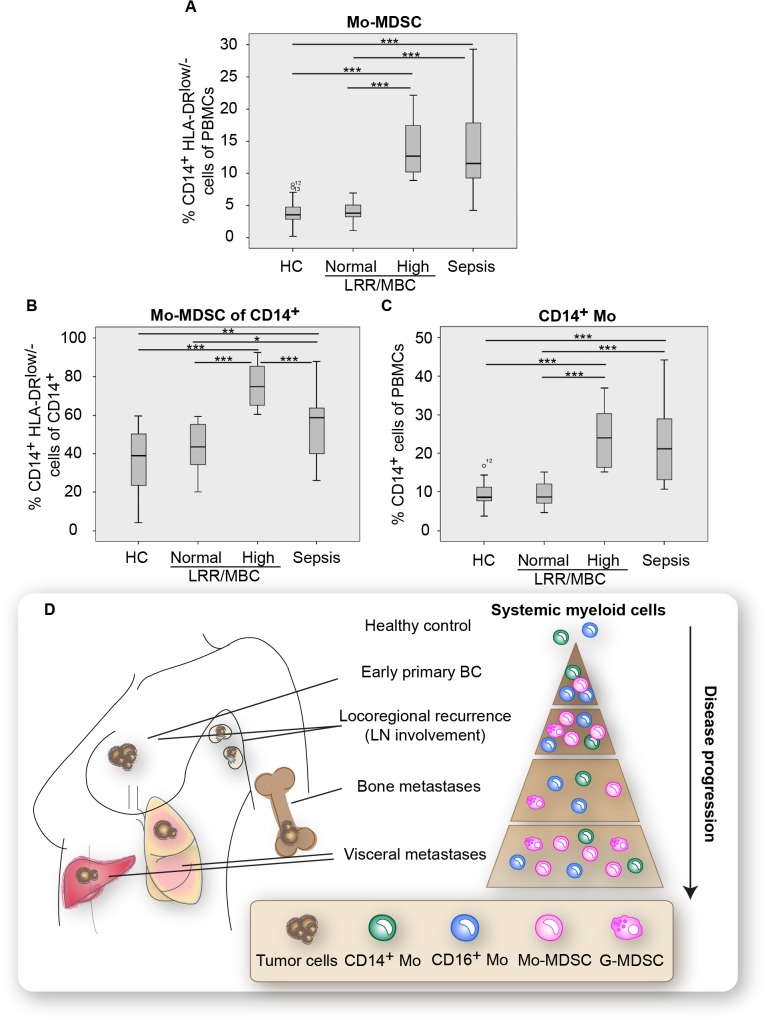
Mo-MDSCs are enriched in a subpopulation of patients with locoregional recurrence or metastatic breast cancer.(A-C) Flow cytometric analyzes of freshly isolated PBMCs from healthy controls (HC), patients with locoregional recurrence or metastatic breast cancer (LRR/MBC) or sepsis. The box plots represents the variation in respective cell population as percentage (%) of PBMCs. Cutoff into “normal” or “high” levels of Mo-MDSCs were based on the highest healthy control value. (A) Percentage of CD14+HLA-DRlow/- monocytes of PBMCs (HC n = 13, LRR/MBC “normal” n = 13, LRR/MBC “high” n = 12, Sepsis n = 18) or (B) within total CD14+ monocyte population (HC n = 13, LRR/MBC “normal” n = 13, LRR/MBC “high” n = 12, Sepsis n = 18). (C) Percentage of total CD14+ monocyte of PBMCs. HC n = 13, LRR/MBC “normal” n = 17, LRR/MBC “high” n = 8, Sepsis n = 18. (D) Cartoon presenting proposed frequencies of relevant systemic myeloid cell populations with disease progression. Abbreviations: Monocytes, Mo; Monocytic-MDSC, Mo-MDSC; granulocytic-MDSC, G-MDSC.